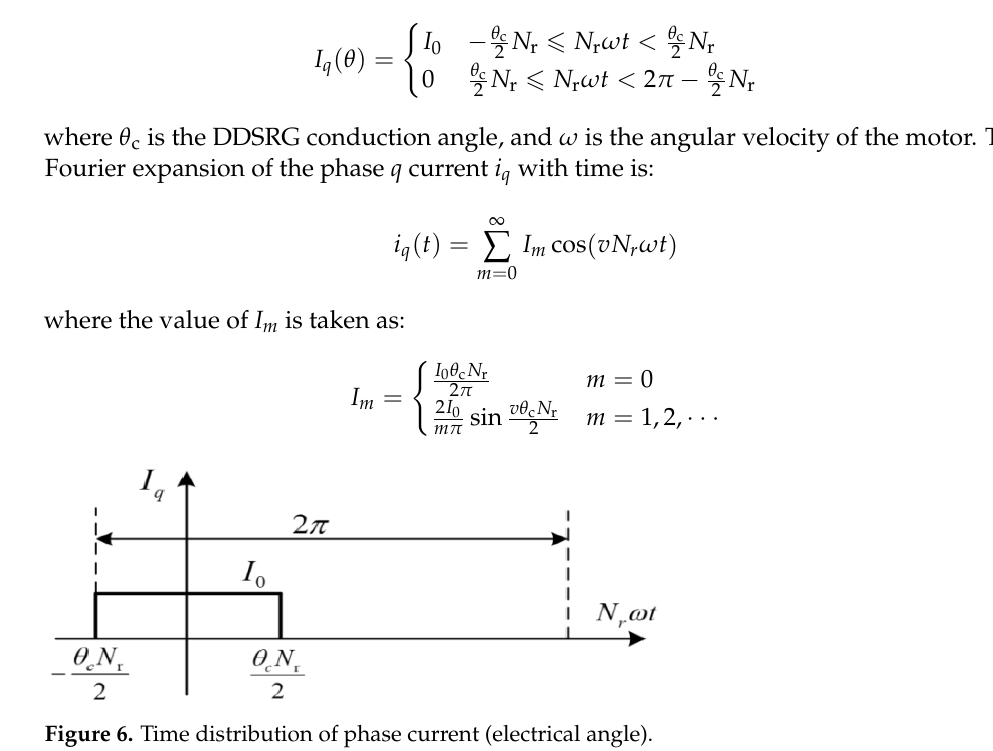
Figure 6. Time distribution of phase current (electrical angle).